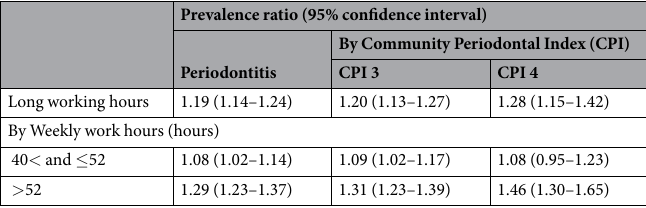
Table 2. Prevalence ratio for periodontitis.